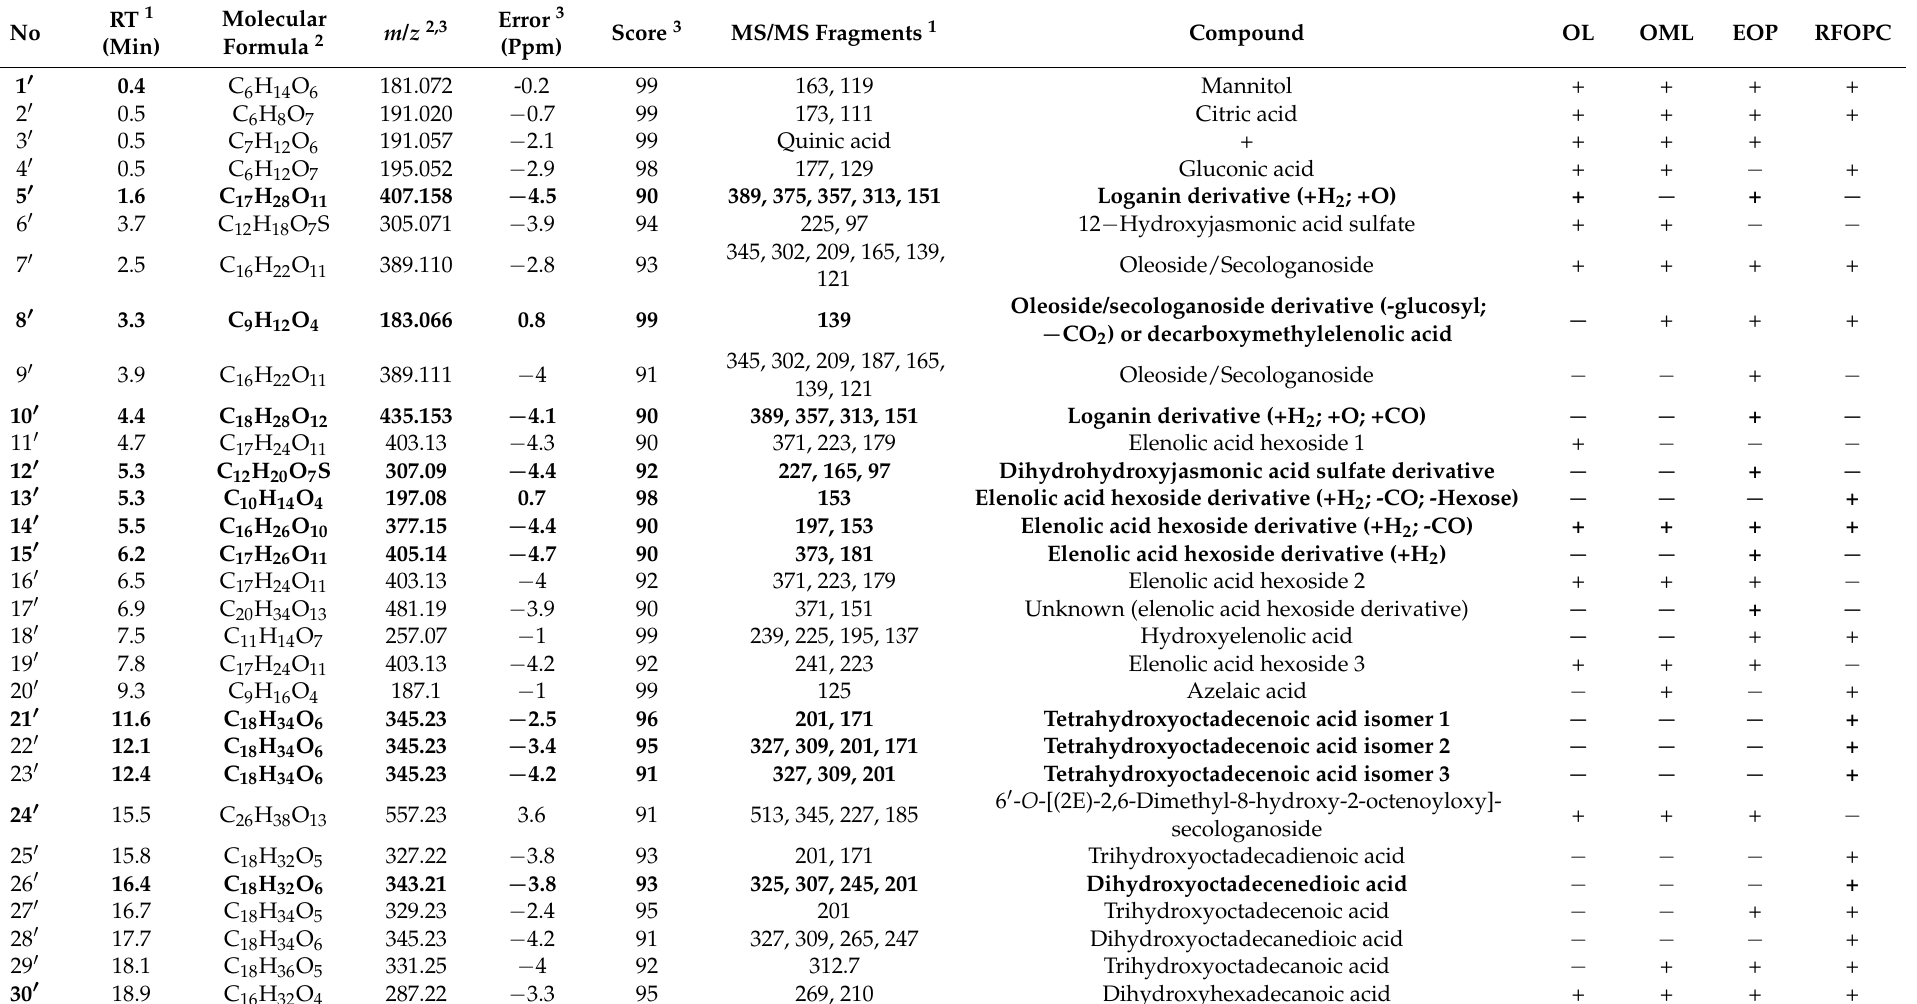
Table 4. Non-phenolic compounds characterized in the extracts from olive leaves (OL), olive mill leaves (OML), exhausted olive pomace (EOP), and residual fraction from olive pit cleaning (RFOPC) obtained by ultrasound-assisted